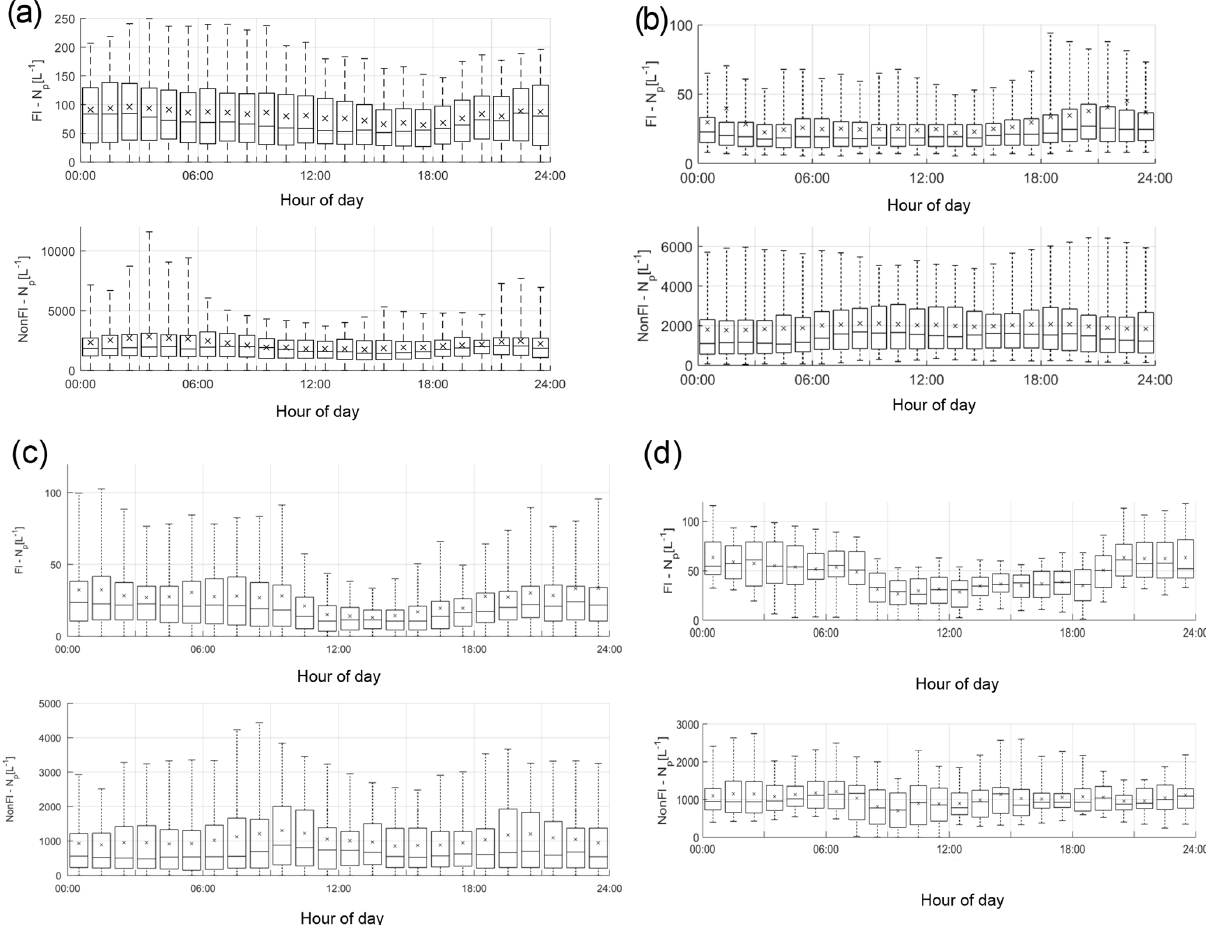
Figure 2. Total fluorescent and non-fluorescent diurnal particle concentration variation at each site (number of particles, N p , in units of L − 1 ) ( a – Davidstow; b – Capel Dewi; c – Chilbolton; d –